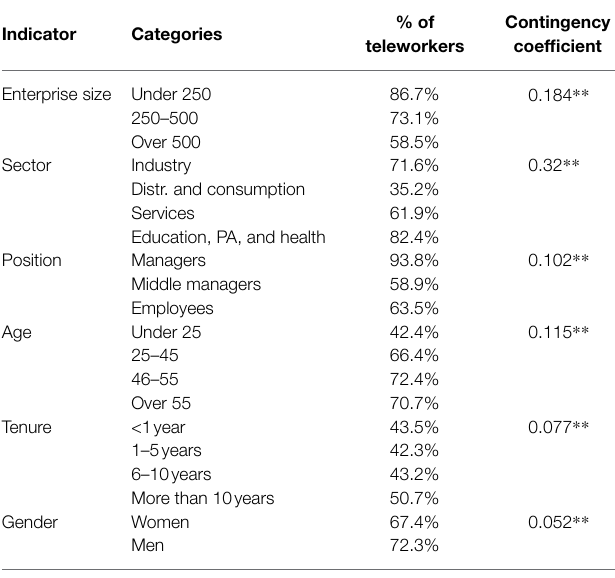
TABLE 2 | Percentage of teleworking employees by sociodemographic and organizational variables. Indicator